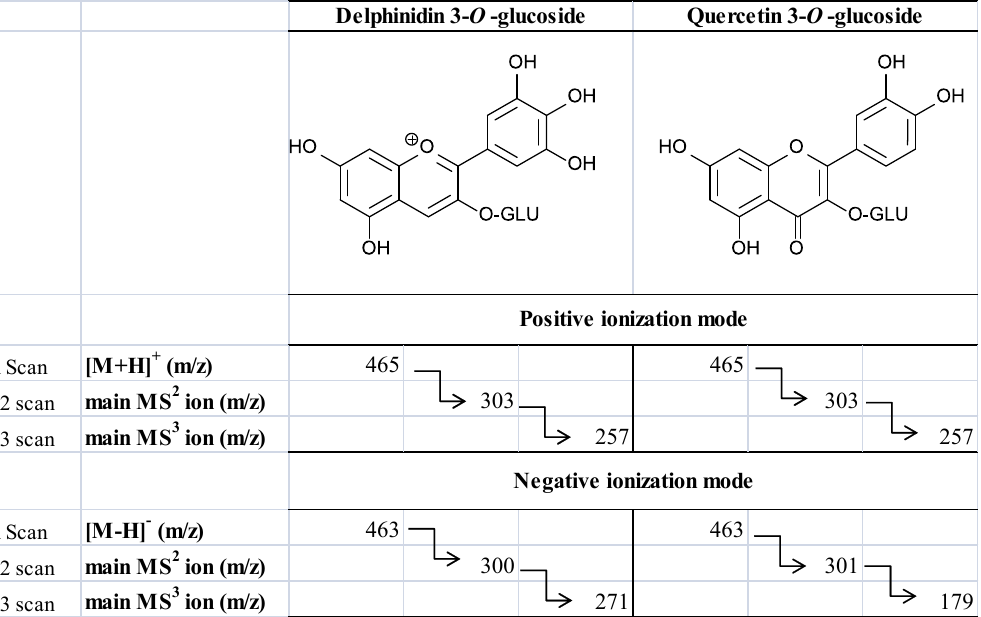
Figure 5. Comparison of the full scan and MS 2–3 scan of delphinidin-3- O -glucoside and quercetin-3- O -glucoside in positive and negative ionization mode. Adapted from Sun et al . 2012